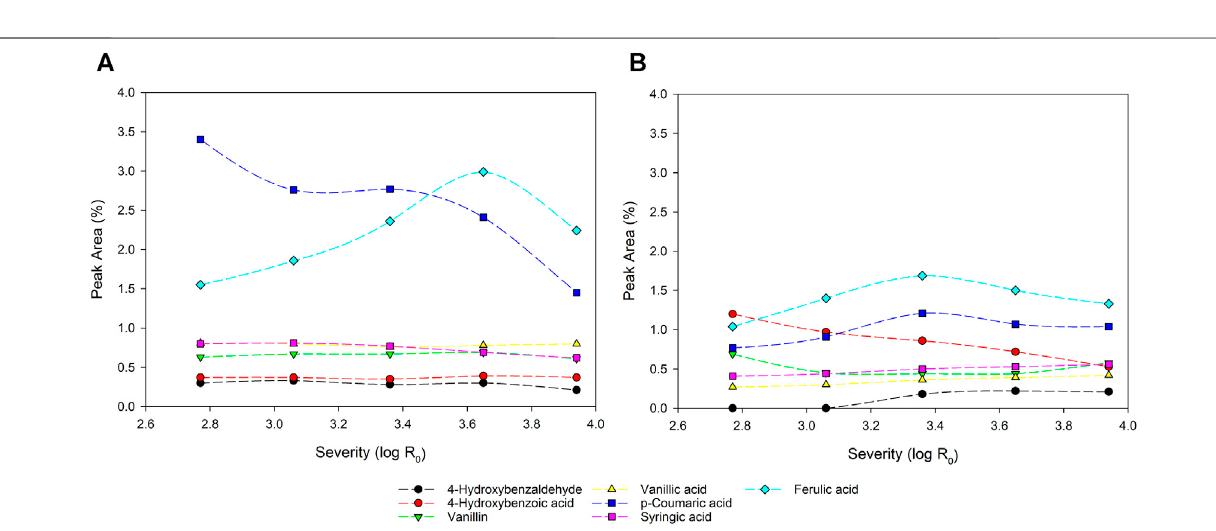
Frontiers in Chemistry |